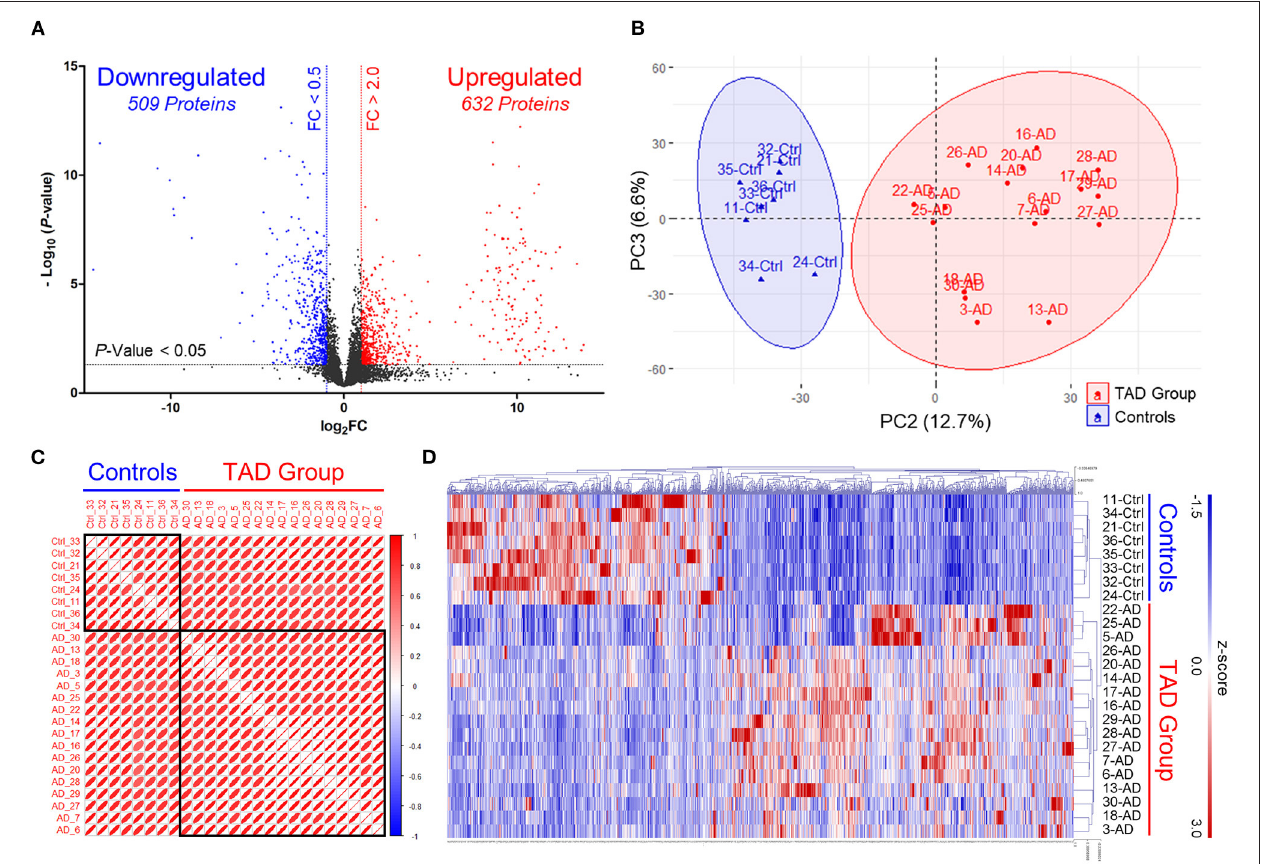
FIGURE 2 | Discovery of differentially expressed proteins via label-free quantitative proteomics profiling. (A) Volcano plots illustrating differentially expressed proteins. Red circles, significantly upregulated proteins in TAD samples. Blue circles, significantly downregulated proteins in TAD samples. Control, MI samples. FC, expression ratios of TAD/Control. (B) Principal component analysis (PCA) plots separate TAD and control samples. Scatter plots show PC2 against PC3. The scatter plots of PC1 against PC2 and PC1 against PC3 are shown in Supplementary Figure 1 . (C) Correlation heatmap shows Pearson’s correlations between all TAD and control samples. Red boxes are grouped by clusters (ward.D). (D) Cluster heatmap of the 632 upregulated and 509 downregulated proteins in TAD samples. Samples are clustered according to Pearson’s